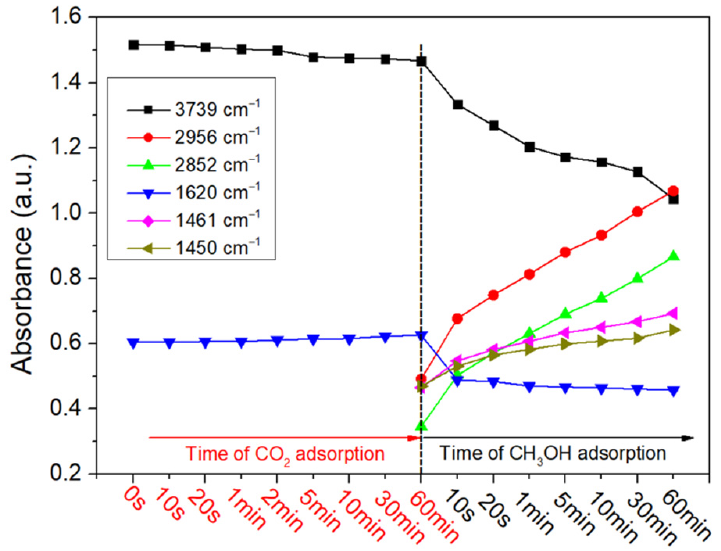
Figure 7. Infrared peak intensities of the different functional groups for Zr-SBA-15 taken during the experiments shown in Supplementary Figures S6 and S7. Peak intensities are normalized from 3739 to 1389 cm − 1 .